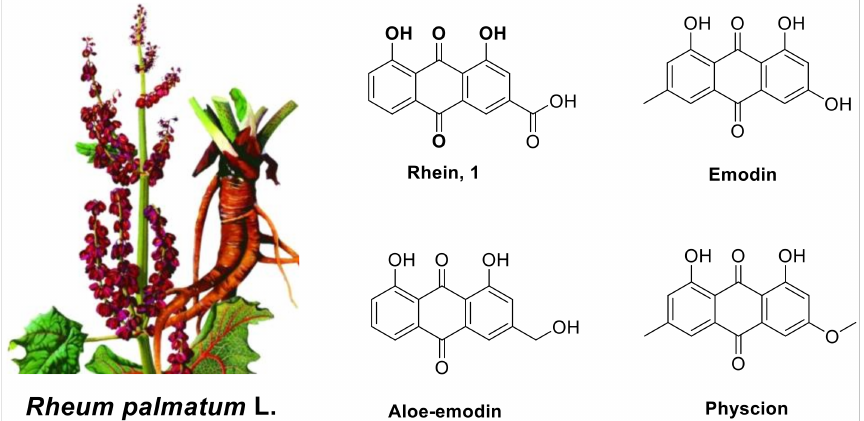
Figure 1. The Rheum palmatum L. and the structures of rhein ( 1 ) and its active analogues emodin, aloe-emodin and